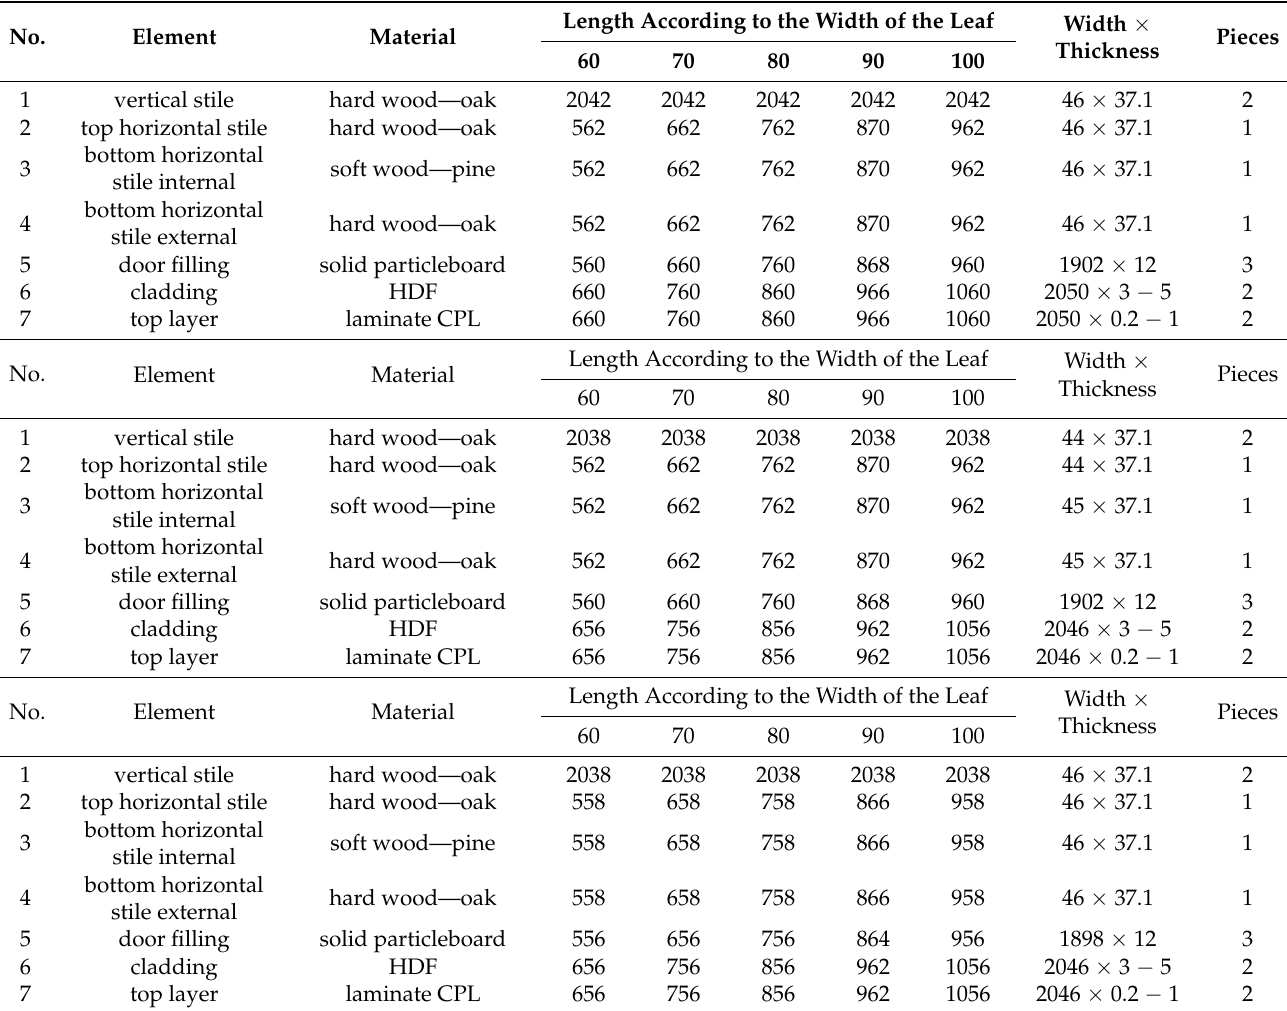
Table 4. Construction 4. Previously used values of machining allowances; reduced machining allowances, variant 1; variant